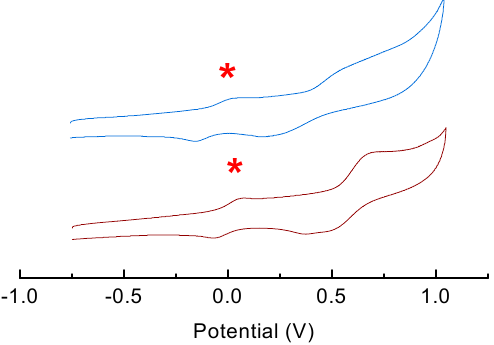
Figure 4. Cyclic voltammetry of Complexes 1 (red line) and 2 (blue line; Ferrocene was referenced by the star).